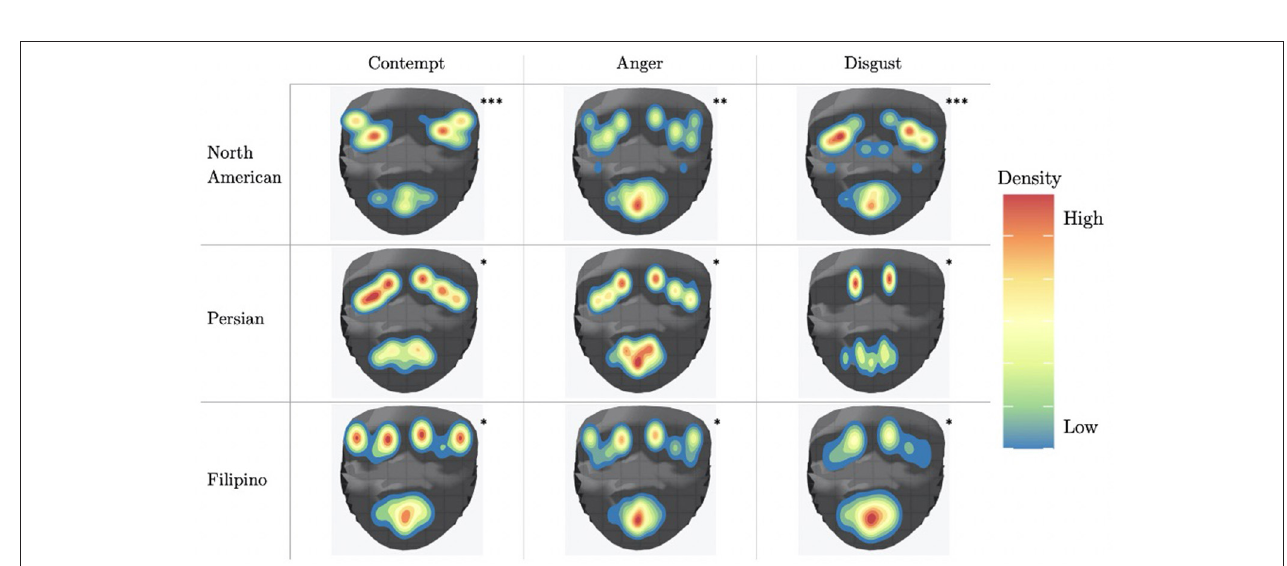
FIGURE 7 | AU activation map that shows the localization of activation using a threshold of 2.5. *Movie/TV shows as primary source; **Mix of Movie/TV shows, Reality TV and Vlogs as primary source; ***Reality TV and Vlogs as primary